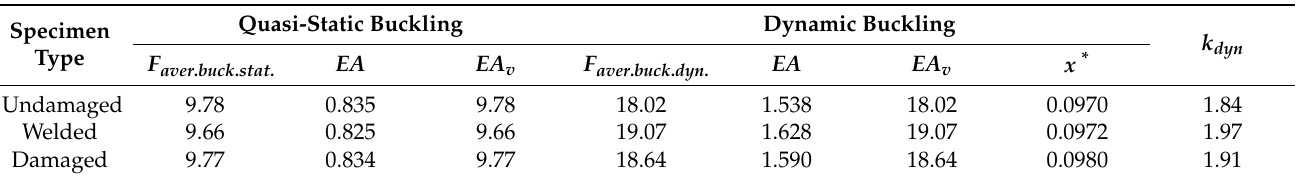
Table 3. The main parameters of specimen buckling obtained during numerical experiments and calculated under axial shortening 0.0854 m of the